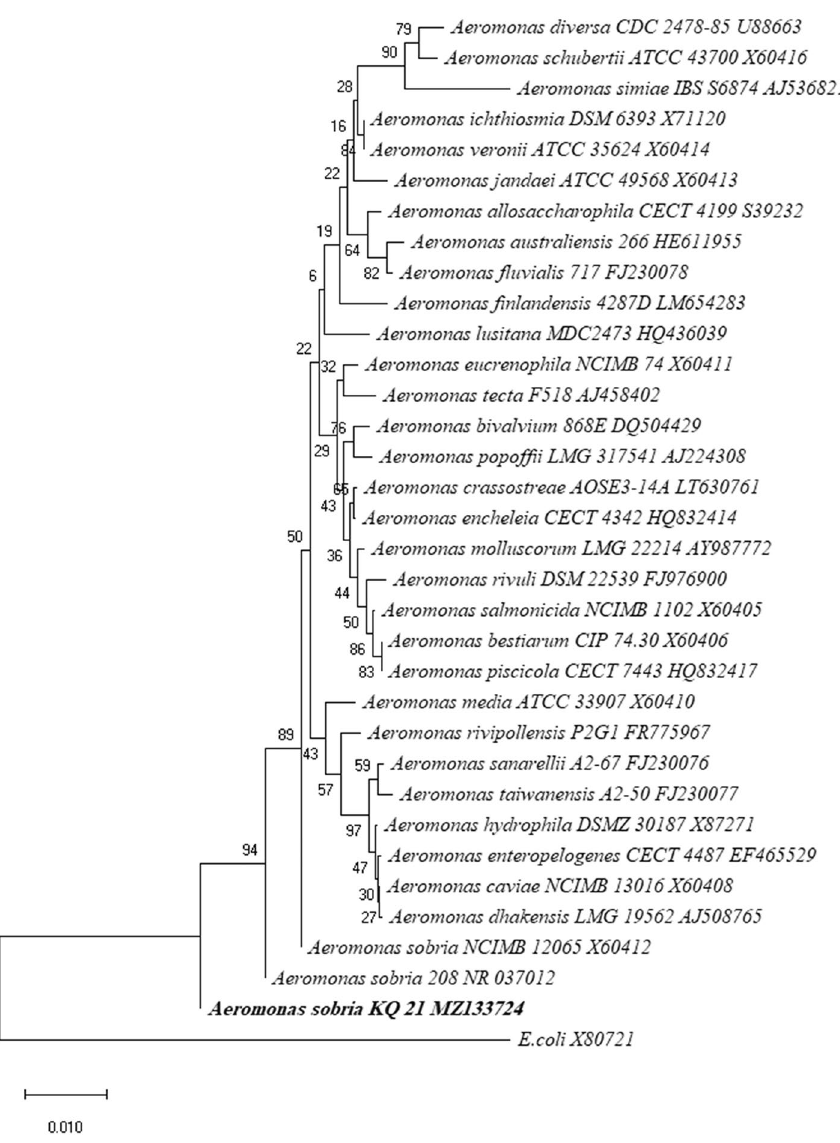
Figure 1. Phylogenetic tree of A. sobria . Phylogenetic tree of A. sobria KQ_21 based on partial 16S rRNA gene